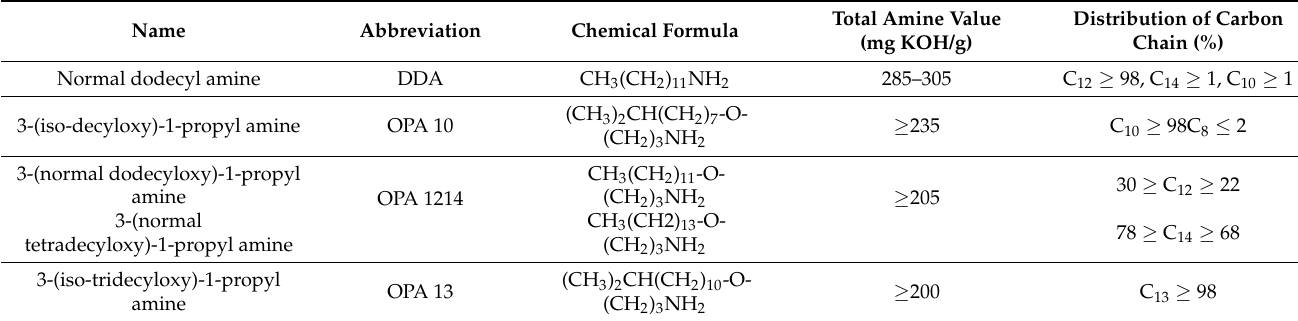
Table 1. Summary of amines used for preparing collectors in batch flotation tests.